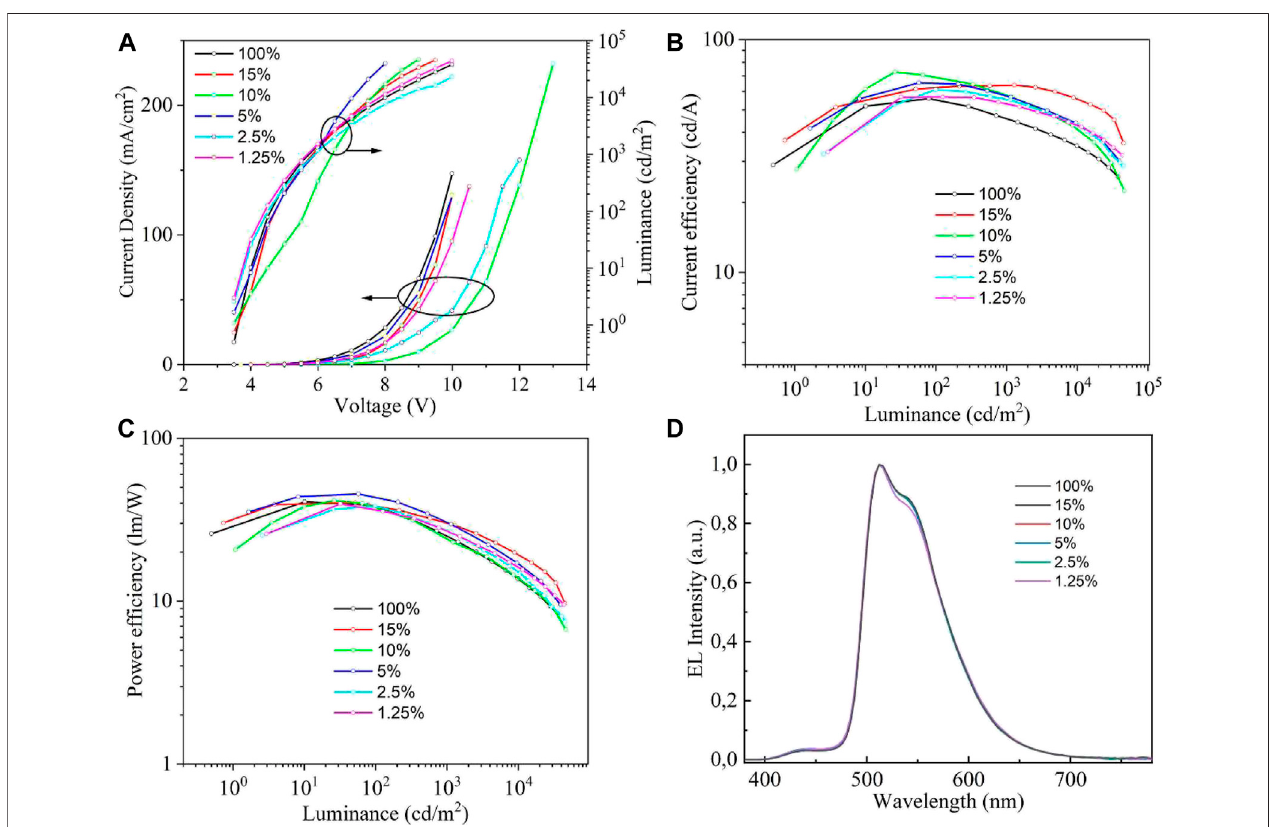
FIGURE7| DeviceperformancewithhybridPEDOT:PSS/MoS 2 QDs fi lmastheHIL. (A) J-V-L , (B) CE- L , (C) PE- J and (D) ELspectraat6 Voftheresultingdevices with different concentrations.